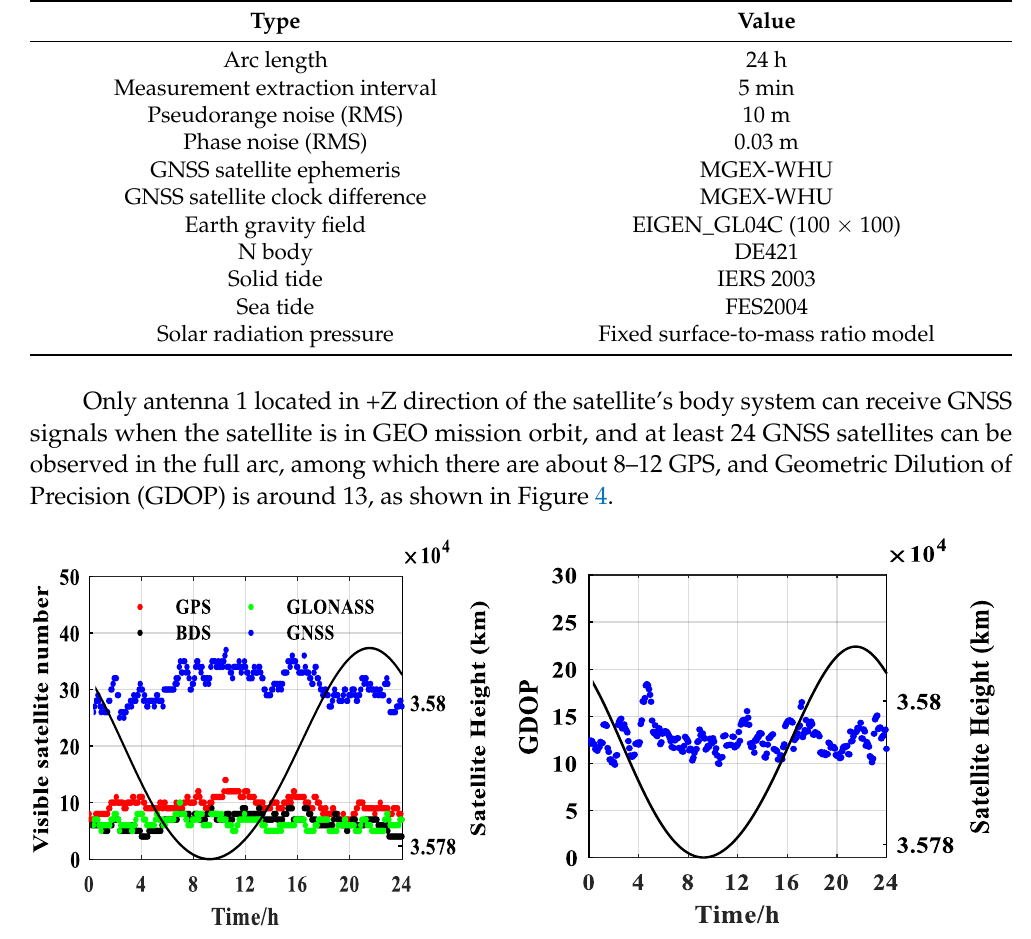
Table 4. Processing strategy for POD.